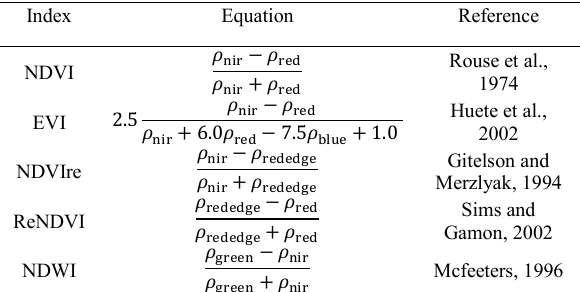
Table 1. Equations for calculating spectral indices. ρ blue , ρ green , ρ red , ρ rededge and ρ nir refer to the reflectance obtained from Blue, Green, Red, Red edge, and Near infrared channels of the RapidEye image.